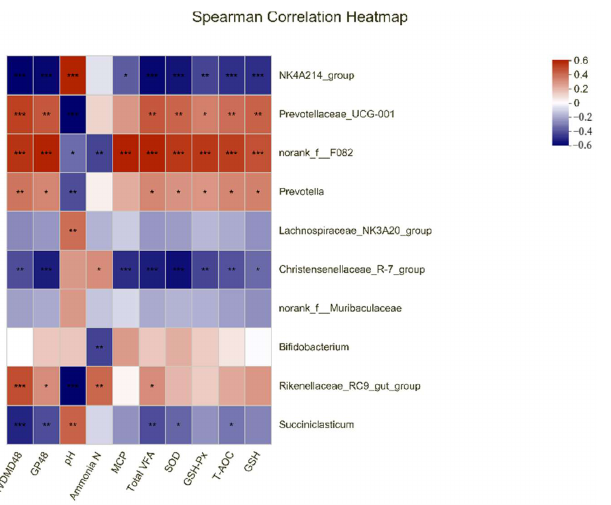
Figure 3. Heat map of the correlations among the top 10 bacterial genera and the parameters of gas production, rumen fermentation, and antioxidant capacity. Color intensity represents p −values